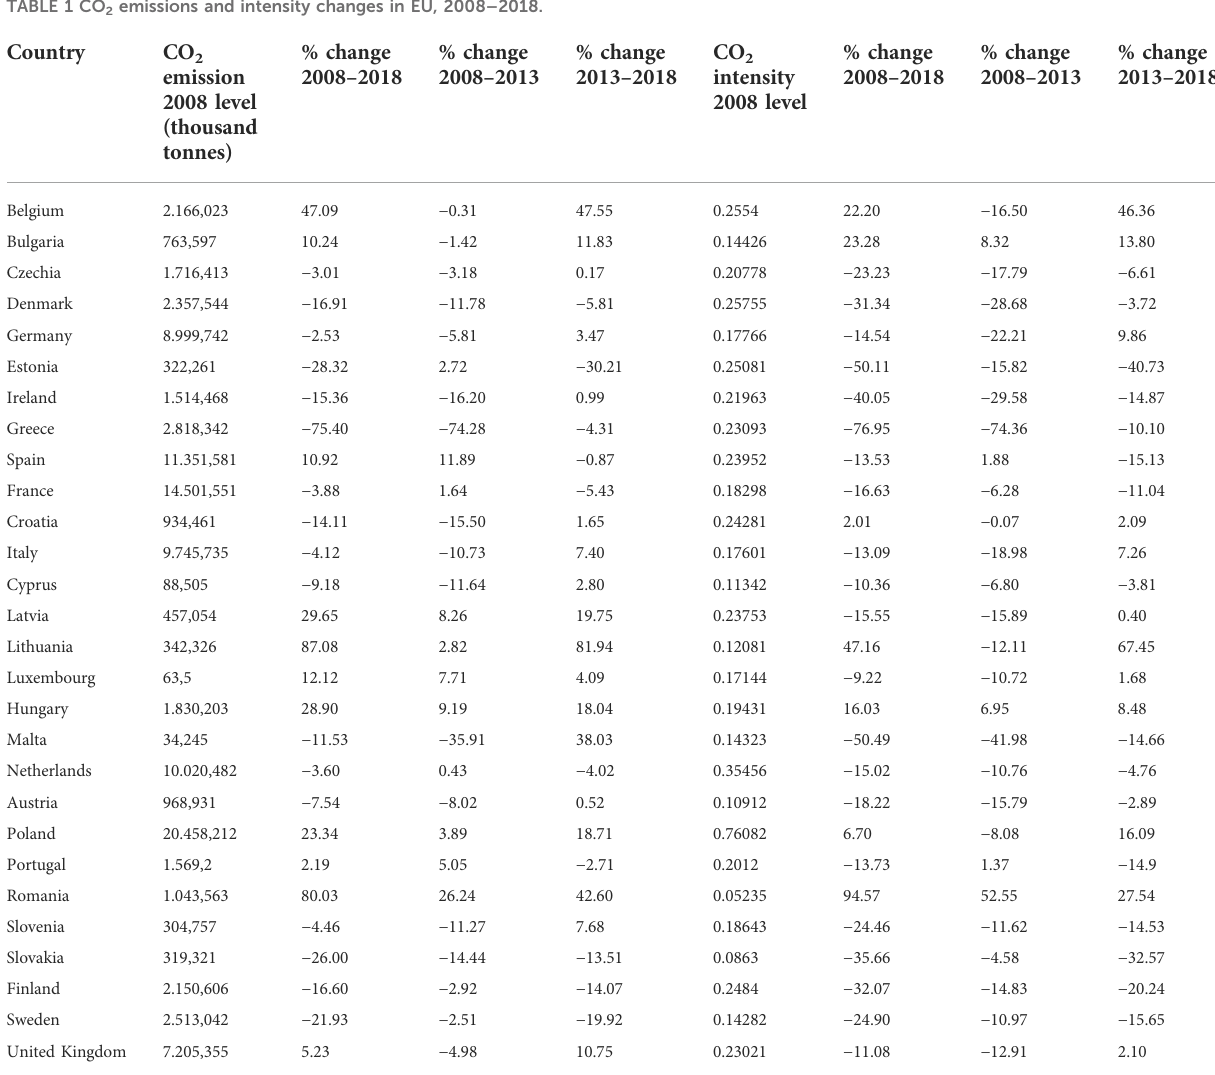
TABLE 1 CO 2 emissions and intensity changes in EU, 2008 –